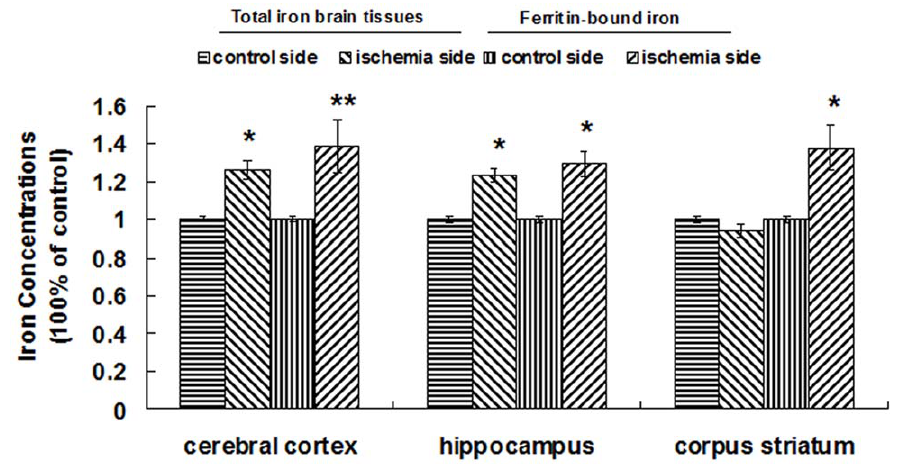
Figure 10. Effect of ischemia/reperfusion on the total iron and ferritin binding iron in the brain. Total iron was masured by ICP-MS, the ferritin bound iron was detected firstly by Immunoprecipitation and ICP-MS. The first two panels in the 3 groups represent the relative total iron concentrations in brain tissues (per milligram of wet brain tissue). The last two panels of 3 groups represent the ferritin-bound iron (per milligram of total protein). The data were presented as mean 6 SEM (100% of control), n=6, *P , 0.05. **P , 0.01.